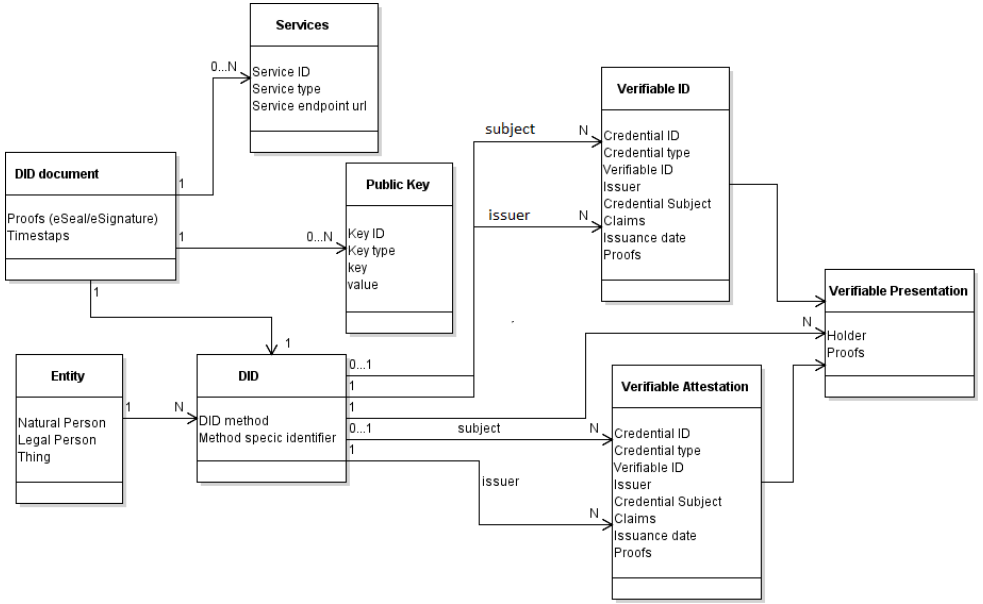
Figure 1. SSI data model proposed by